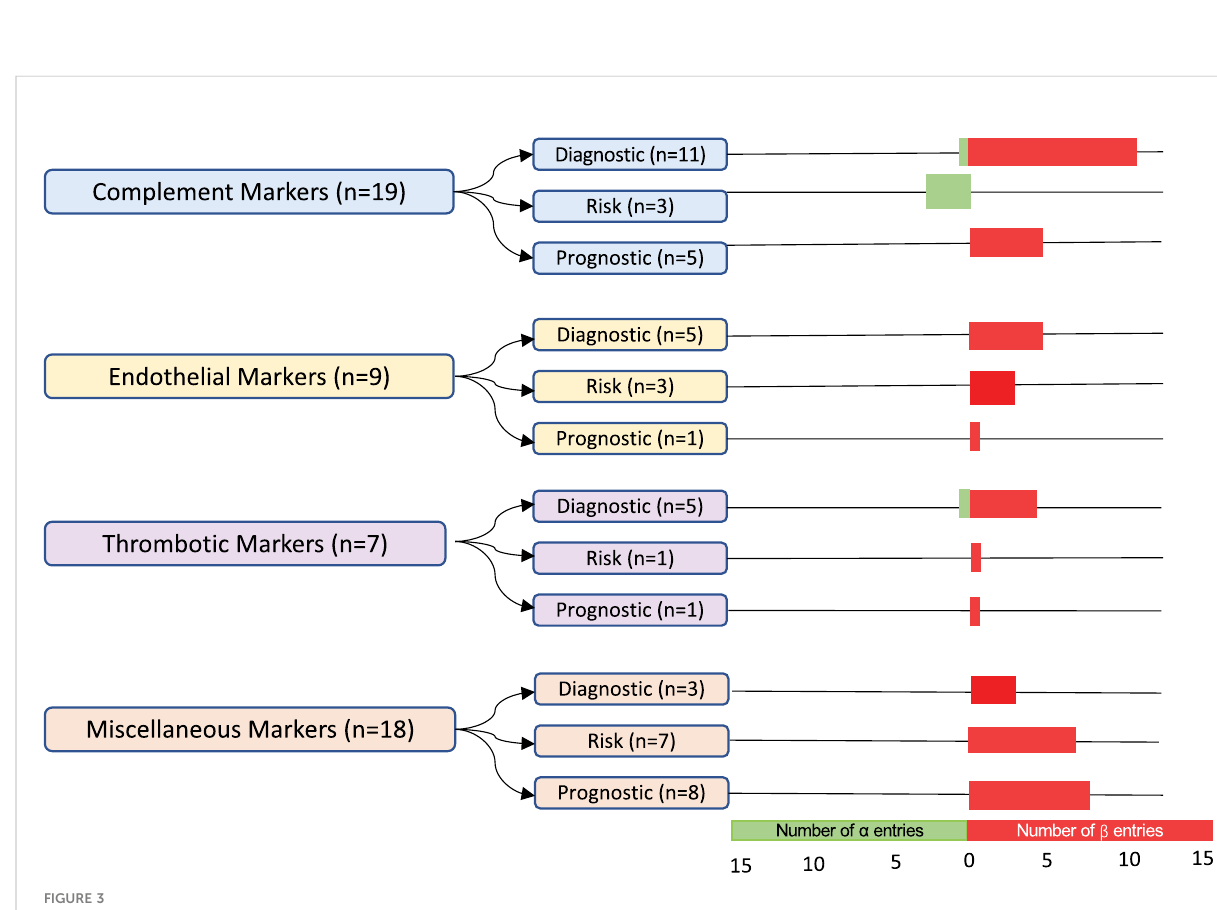
FIGURE 3 Classi fi cation and number of entries per biomarker category. In total, 53 biomarker entries from a set of 31 studies were included. The a -group entries included sensitivity and speci fi city values and post-HCT controls. The b -group entries lacked either or both of these features. Biomarkers were grouped into markers of complement activation, endothelial activation, thrombosis, and miscellaneous. They were further subdivided into diagnostic, risk, and prognostic biomarkers. The number of a -group entries is indicated in green, and the number of b -group entries is in